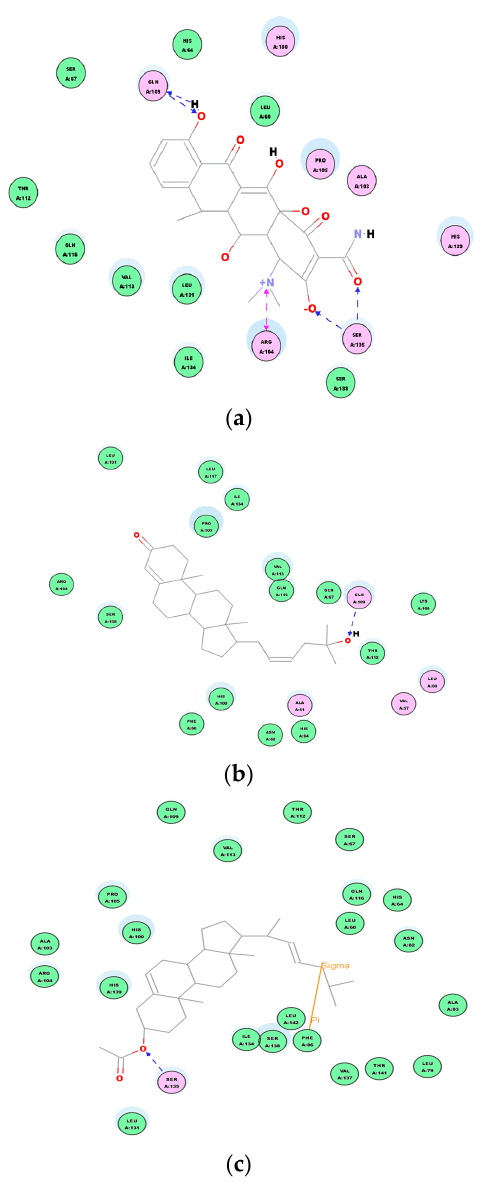
Figure 11. Ligand interaction of compounds 1 , 2 in the active site of target protein 2XRL. ( a ) 2D intermolecular forces and interaction of doxycycline and receptor protein 2XRL. ( b ) 2D intermolecular forces interaction of compound 1 receptor protein 2XRL. ( c ) 2D intermolecular forces interaction of compound 2 receptor protein 2XRL.